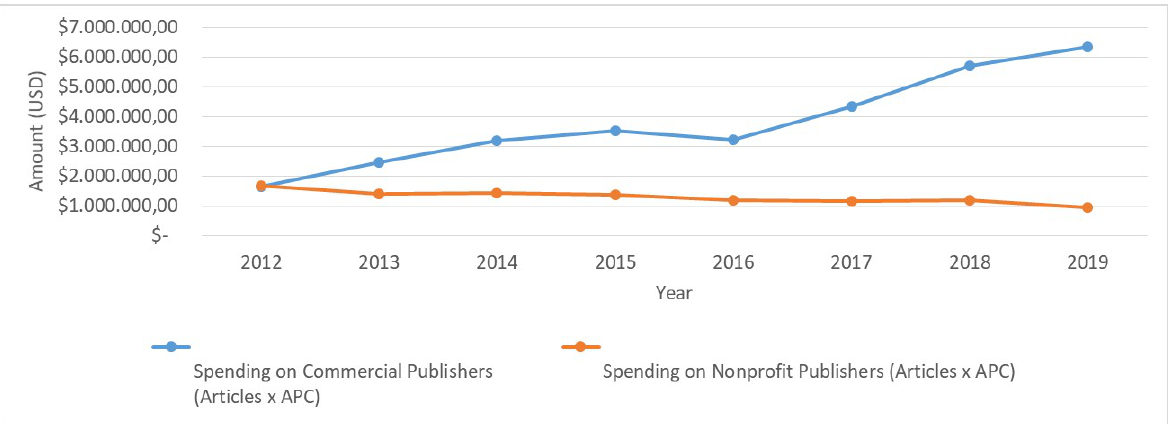
Figure 3. Total amounts spent on APCs from commercial Publishers and non-profit publishers in the 2012-2019 period. (Source: the authors).